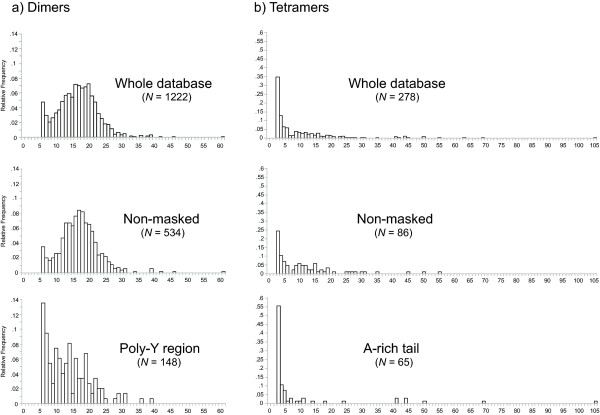
Frequency distribution of repeat array length. Relative frequency of repeat array length (number of repeats) for the most abundant motif classes – a) dimers and b) tetramers – in: the whole database, non-masked clones, poly-Y region and A-rich tail.